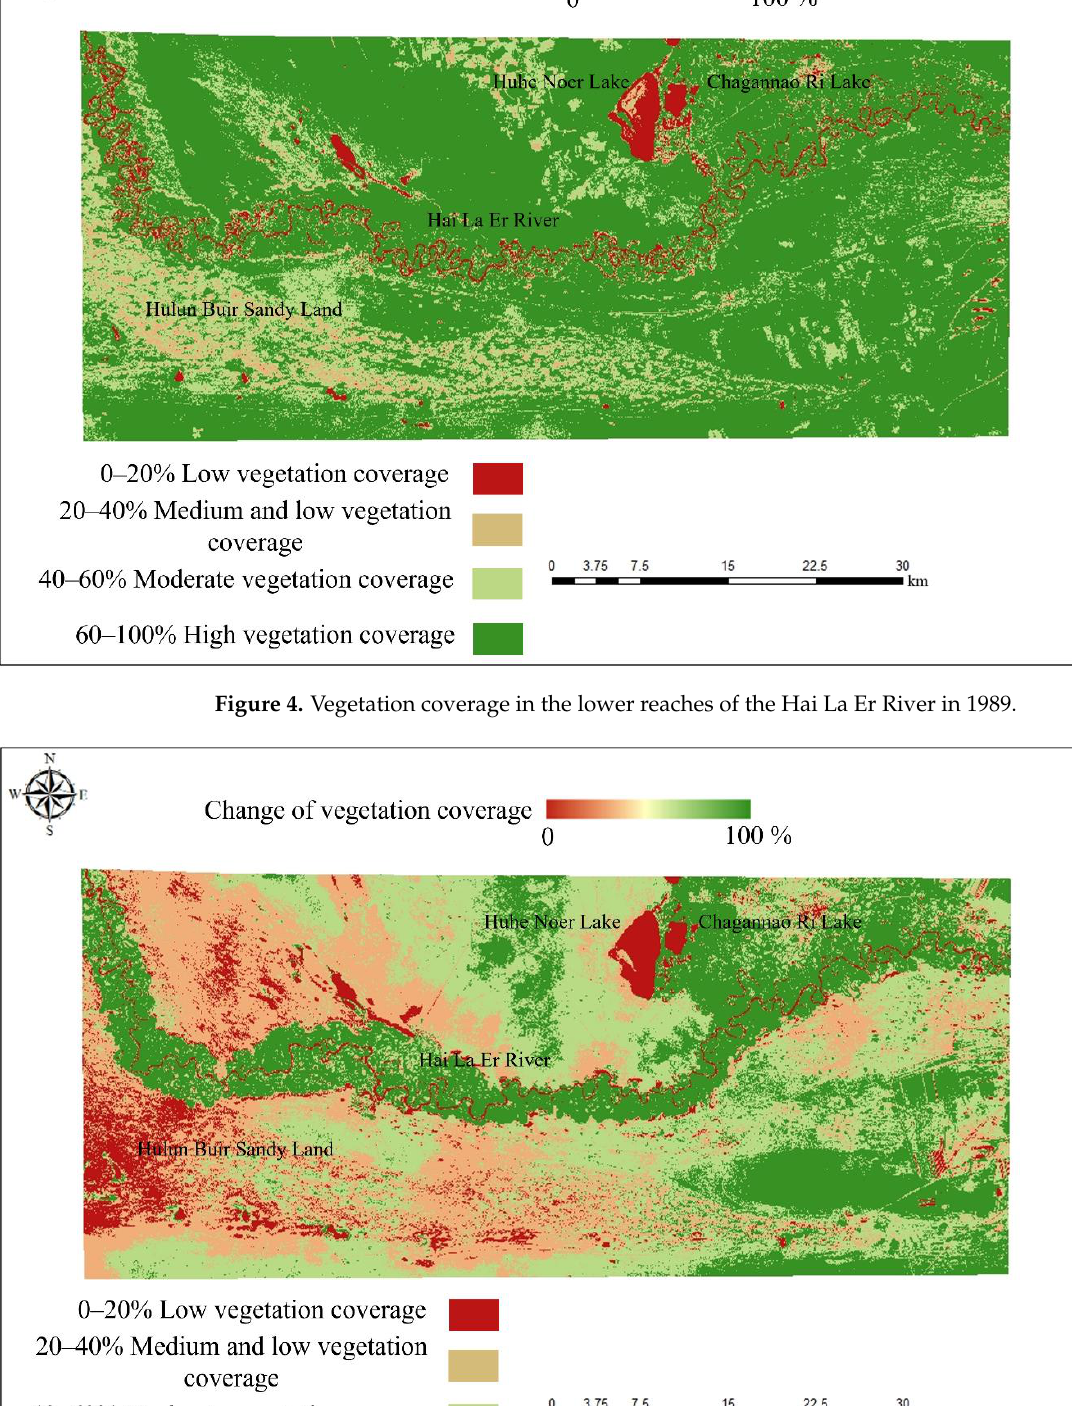
Figure 5. Vegetation coverage in the lower reaches of the Hai La Er River in 1999.